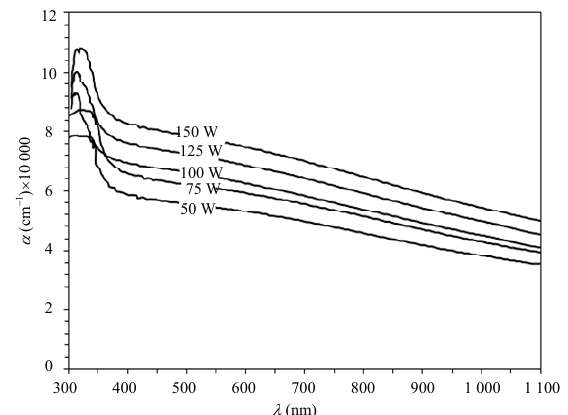
Fig. 5 Absorption coefficient as a function of wavelength for (Ti6Al4V) thin film at different working RF